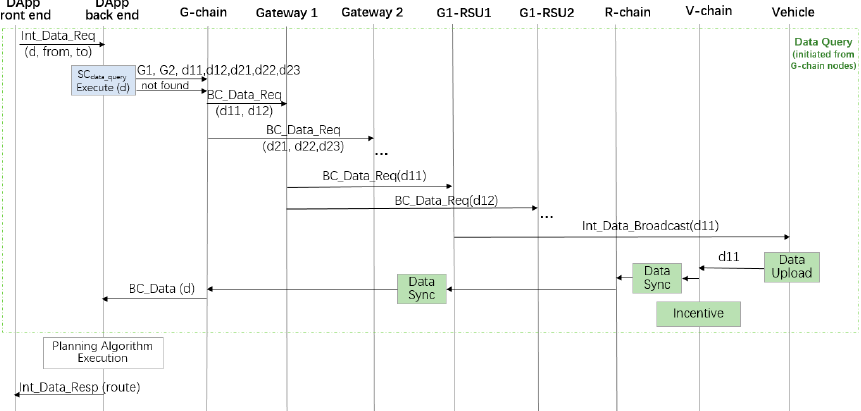
Figure 5. Data query when no data are found in the blockchain.